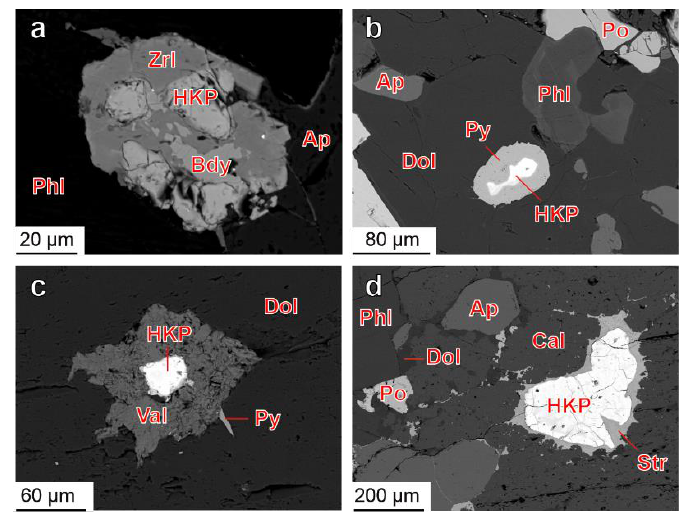
Figure 3. Typical products of hydroxykenopyrochlore low-temperature alteration: a —replacement of baddeleyite and hydroxykenopyrochlore by zirconolite in dolomite carbonatite 964/148.2; b —relic of hydroxykenopyrochlore within pyrite grain in phlogopitite 948/31.4; c —radiated aggregate vallereite around hydroxykenopyrochlore grain in vein calcite carbonatite 943/54.7; d —hydroxykenopyrochlore grain rimmed by strontianite in phoscorite-related calcite carbonatite 974/115.6. BSE-images of polished thin sections. Mineral abbreviations are in Section 2.